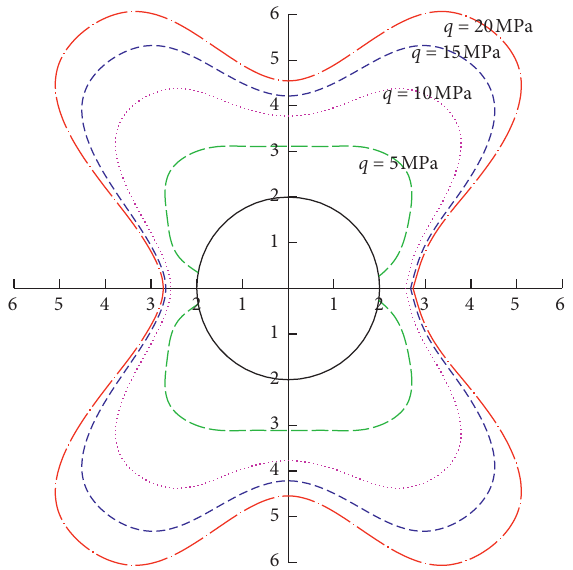
Figure 5: The distribution range of the plastic zone with different vertical pressure.